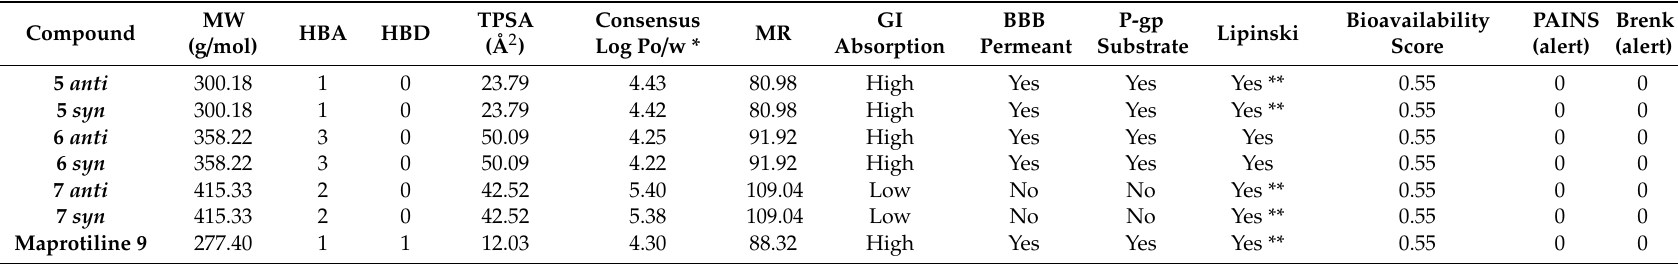
Table 6. Physicochemical, pharmacokinetics, and medicinal chemistry properties of the compounds (5–7) anti , (5–7) syn, and Maprotiline 9 using SwissADME server.